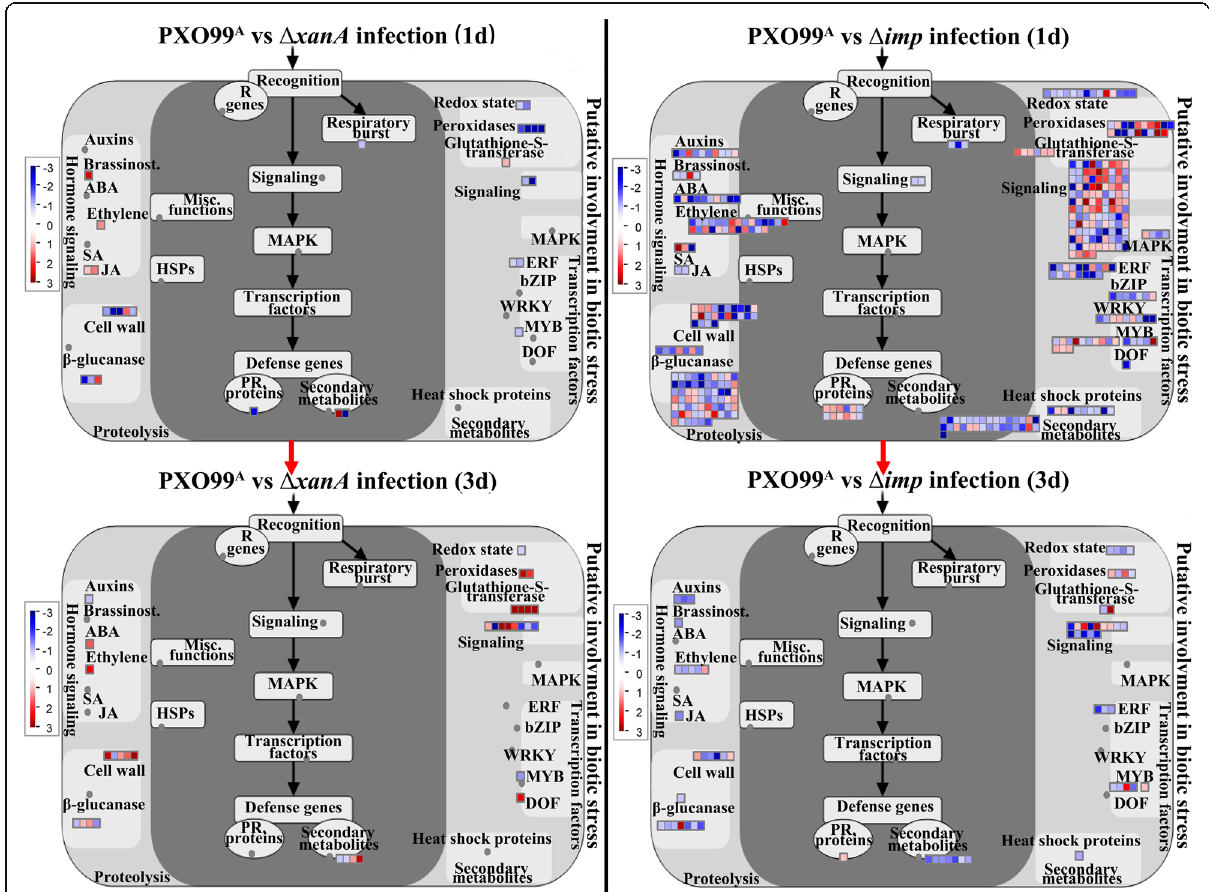
Fig. 7 MapMan visualization and comparison of the DEGs associated with the biotic stress pathway among IR24 rice infected by PXO99 A , Δ xanA or Δ imp at 1 and 3 dpi. In each comparison group, the corresponding DEGs with |log2 (fold change)| ≥ 1 were imported into MapMan software. The gray circles indicate missing data. The DEGs successfully matched to the biotic stress pathway are represented by colored squares, where the red squares and blue squares indicate up- and downregulated genes, respectively. The color intensity represents the gene expression level (log2 ratio mutant/PXO99 A ), as indicated by the color scale. Detailed information is presented in Table